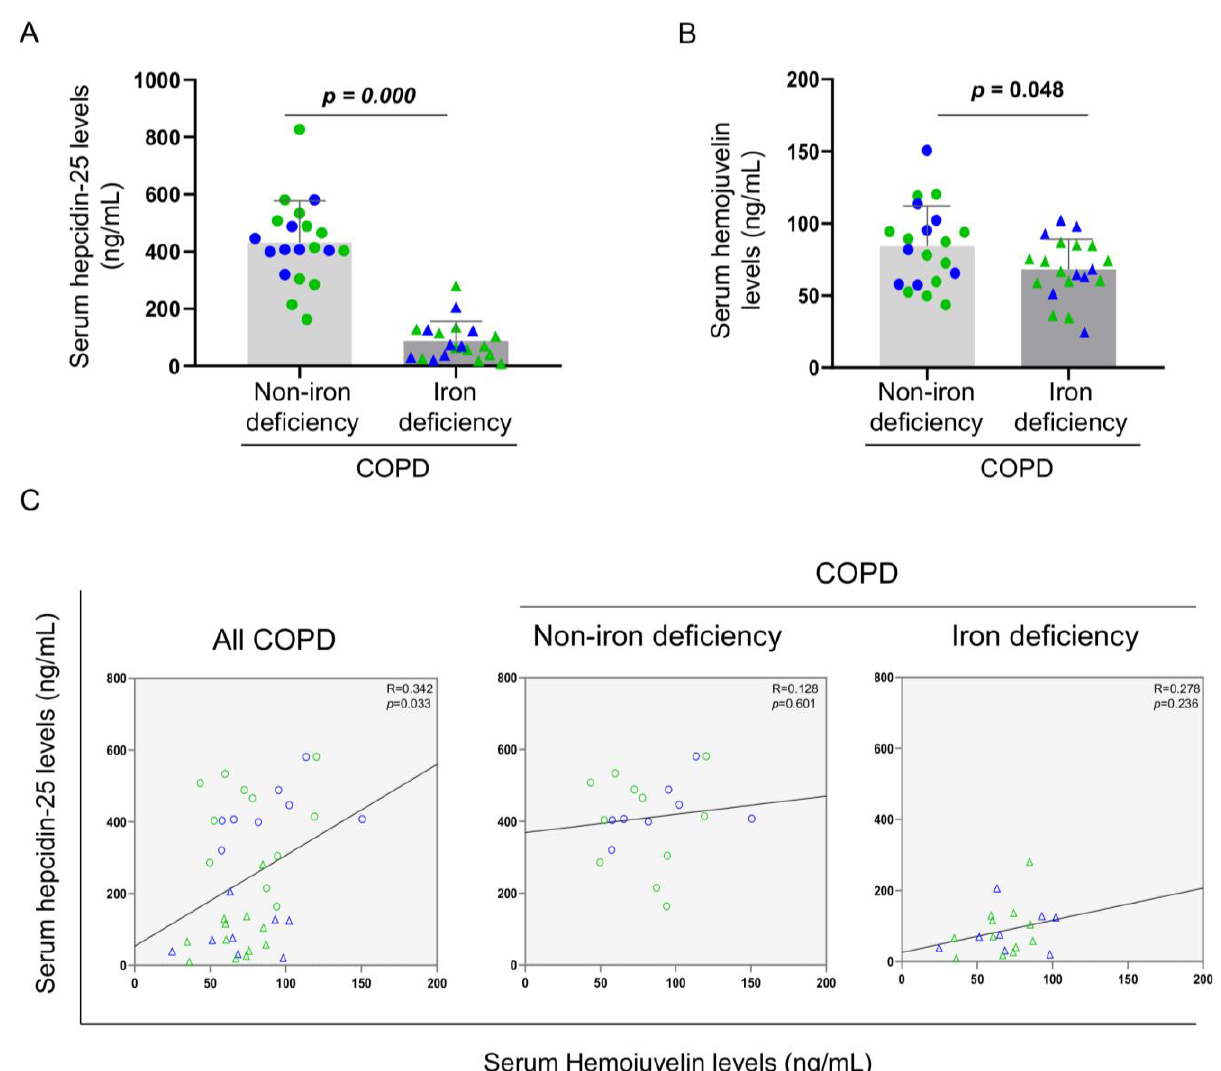
Figure 2. Mean values and standard deviation of ( A ) serum hepcidin-25 (ng/mL) and ( B ) hemojuvelin (ng/mL) variables in COPD patients. ( C ) Scatter plots representation of correlations between serum hepcidin and serum hemojuvelin in all COPD patients ( left panel), non-iron deficiency ( middle panel) and iron deficiency ( right panel) COPD patients. In the graphs, the green color dots or triangles indicate male patients in either study group, while the blue color dots or triangles indicate female patients in the same groups. Definition of abbreviations: COPD, chronic obstructive pulmonary disease. Adjusted p values for gender differences are shown in the graphs.